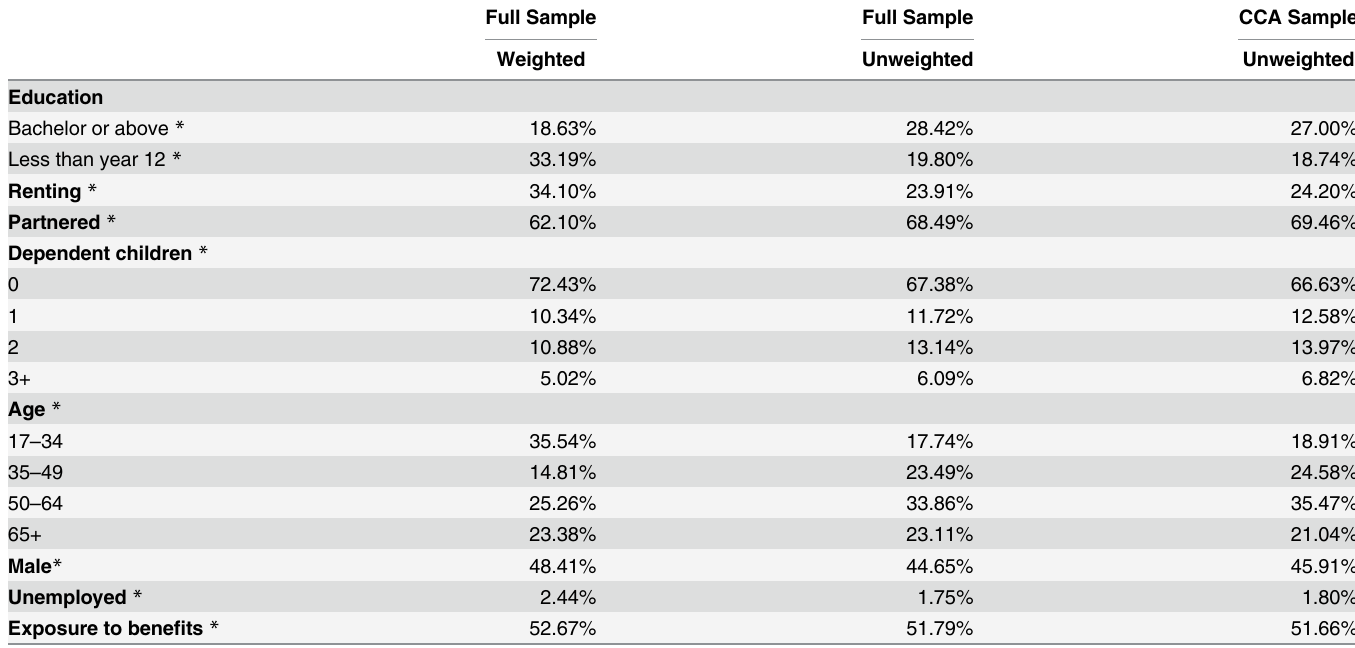
Table 2. Demographic characteristics of the